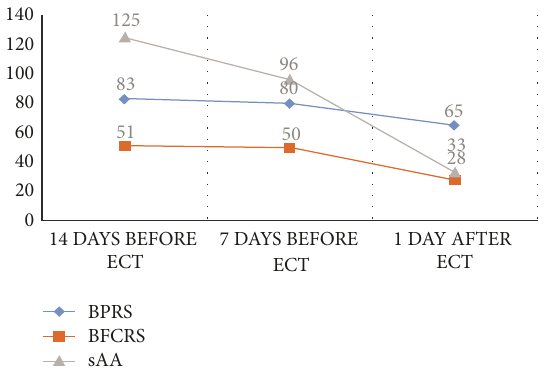
Figure 1: The relationship between the patient’s salivary alpha- amylase activity levels (kU/l) and scores for the Brief Psychiatric Rating Scale (BPRS) and Bush–Francis Catatonia Rating Scale